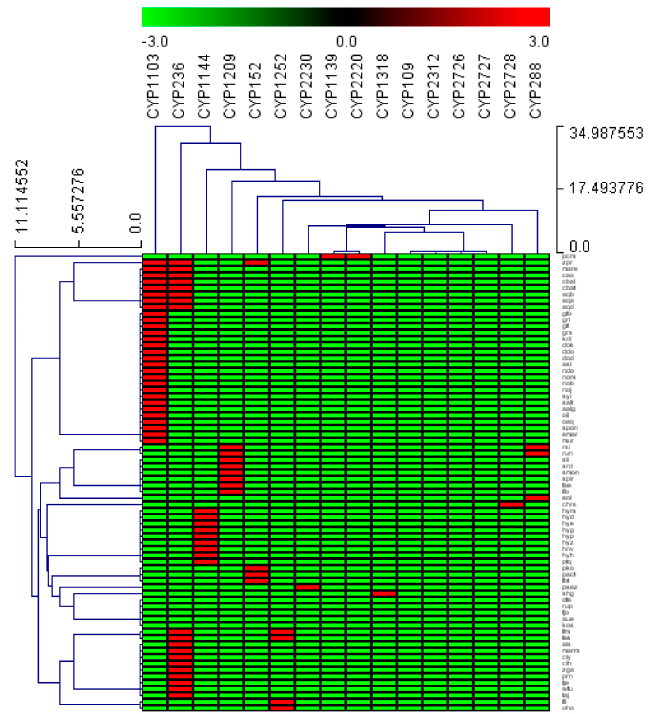
Figure 3. Analysis of P450 family absence/presence and co-occurrence in Bacteroidetes species. The data have been represented as − 3 for family absence (green) and 3 for family presence (red). There are 77 Bacteroidetes species that form the horizontal axis, and 21 P450 families form the vertical axis.